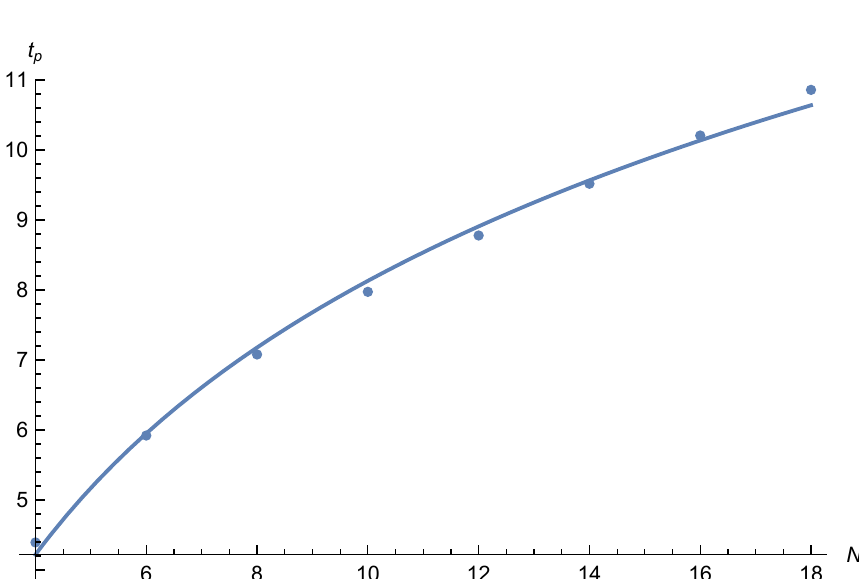
JHEP01(2018)049